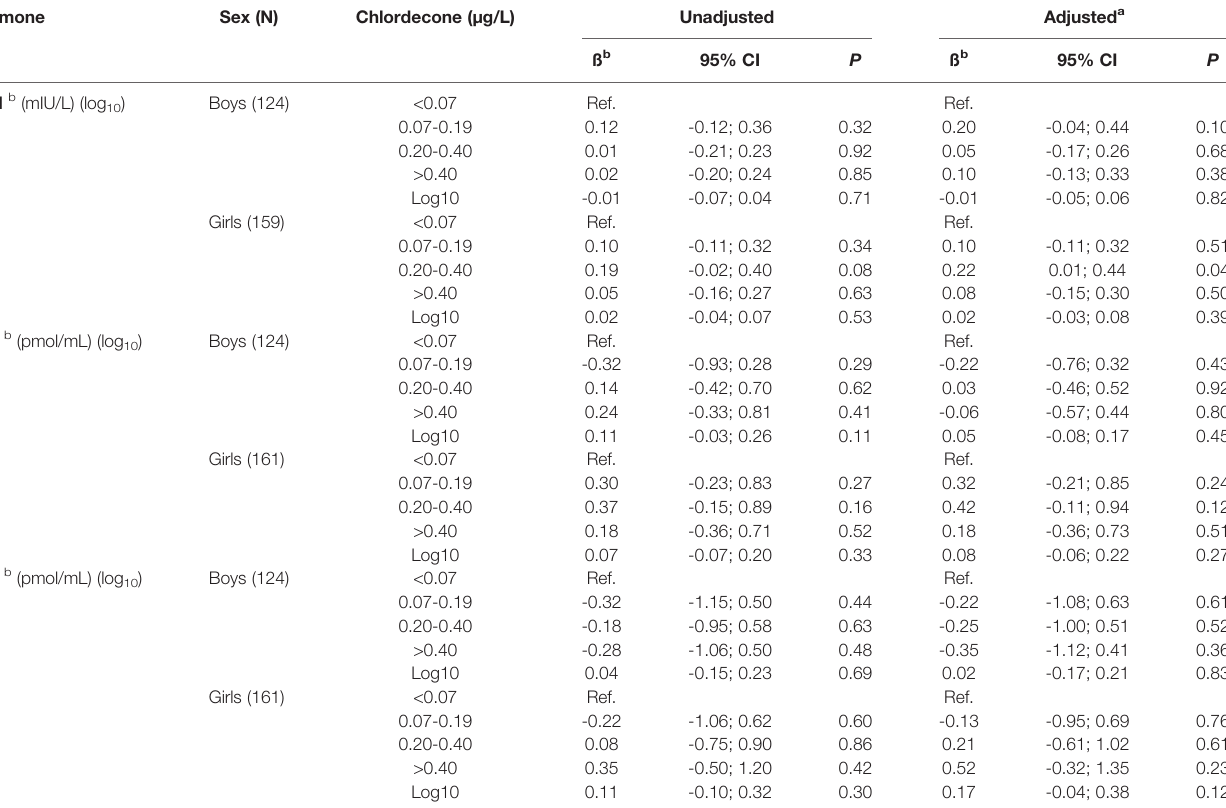
TABLE 4 | Associations between in utero (cord blood) chlordecone exposure and thyroid hormone concentrations at seven years of age in children of the TIMOUN cohort. Hormone Sex (N) Chlordecone (µg/L)